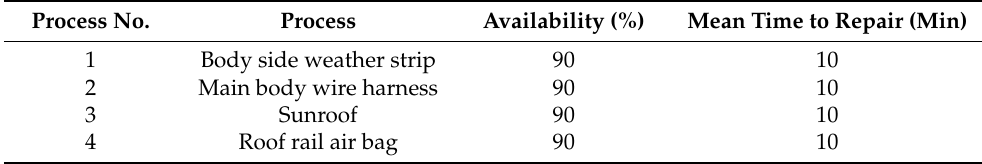
Table 2. Availability and mean time to repair settings of each station in Case A.